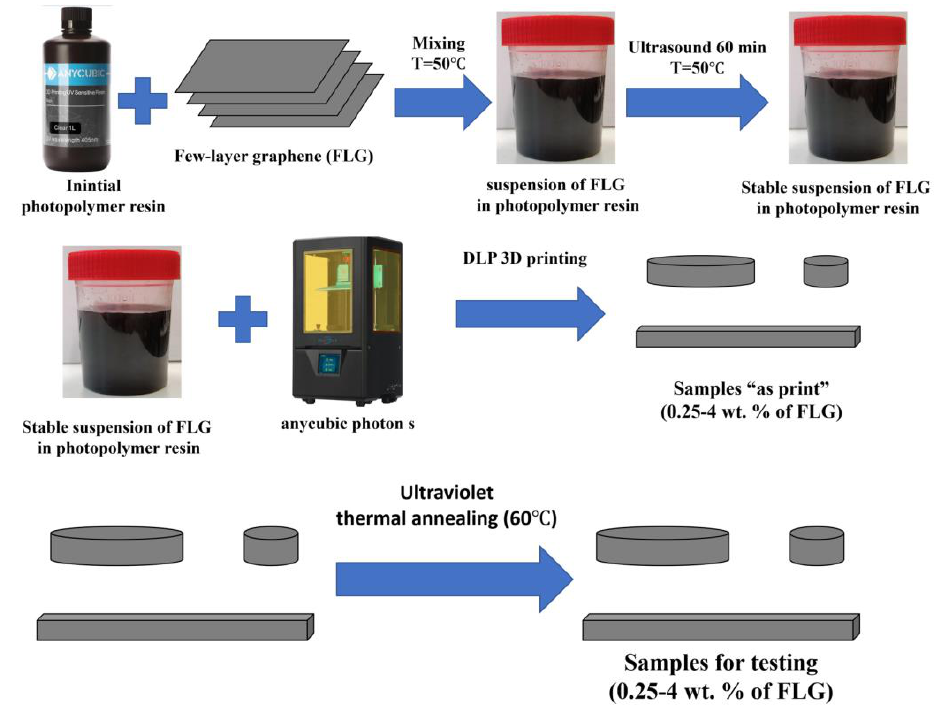
Figure 1. Scheme for obtaining samples from photopolymer resins with the addition of FLG.